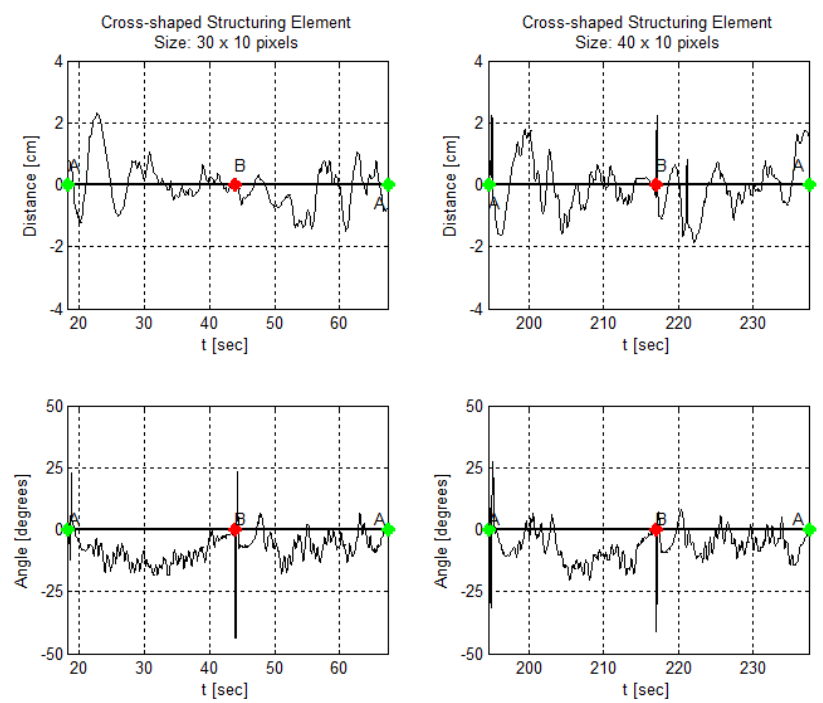
Figure 26. AGV angle and distance measures using a cross-shaped kernel in the morphological operation at the image processing